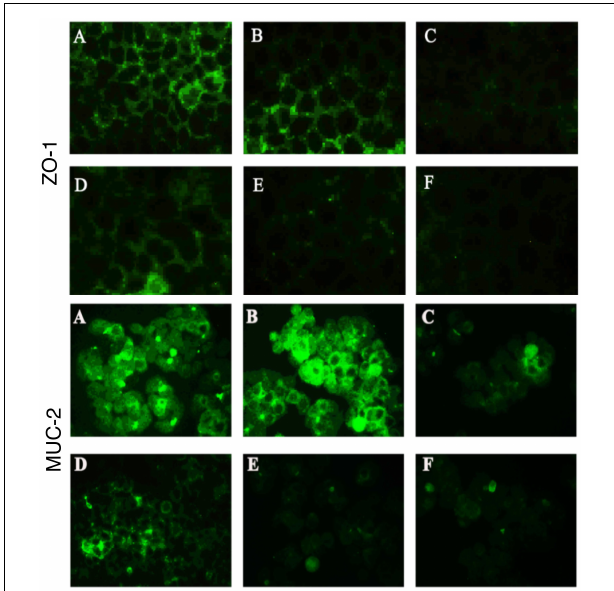
FIGURE 5 | Bacteroides fragilis ZY-312 increases expression of the tight junction protein ZO-1 and mucin MUC-2 in colon cells infected with C. difficile . Representative images for immunofluorescence staining of tight junction protein ZO-1 (top) in Caco-2 cells and mucin Muc-2 (middle) in HT-29 cells are shown for all groups. (A) Blank control group, 4 × 10 4 Caco-2 or HT-29 cells were cultured without treatment. (B) B. fragilis group, cells were incubated with 4 × 10 7 cfu B. fragilis . (C) C. difficile group, cells were incubated with 4 × 10 6 cfu C. difficile . (D) Exclusion group, cells were infected with 4 × 10 7 cfu B. fragilis for the first hour and 4 × 10 6 cfu C. difficile for the second hour. (E) Competition group, cells were co-infected with B. fragilis and C. difficile . (F) Substitution group, C. difficile was added for the first hour and B. fragilis added at the second hour. The cells were incubated at 37 ◦ C under anaerobic conditions for 2